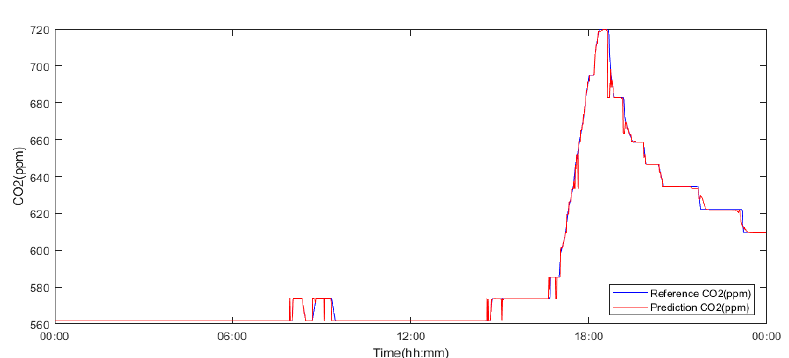
Sensors 2019 , 19 , 1407 Figure 12. Model number 9 trained and validated using data from yjr 15 th of May 2018.